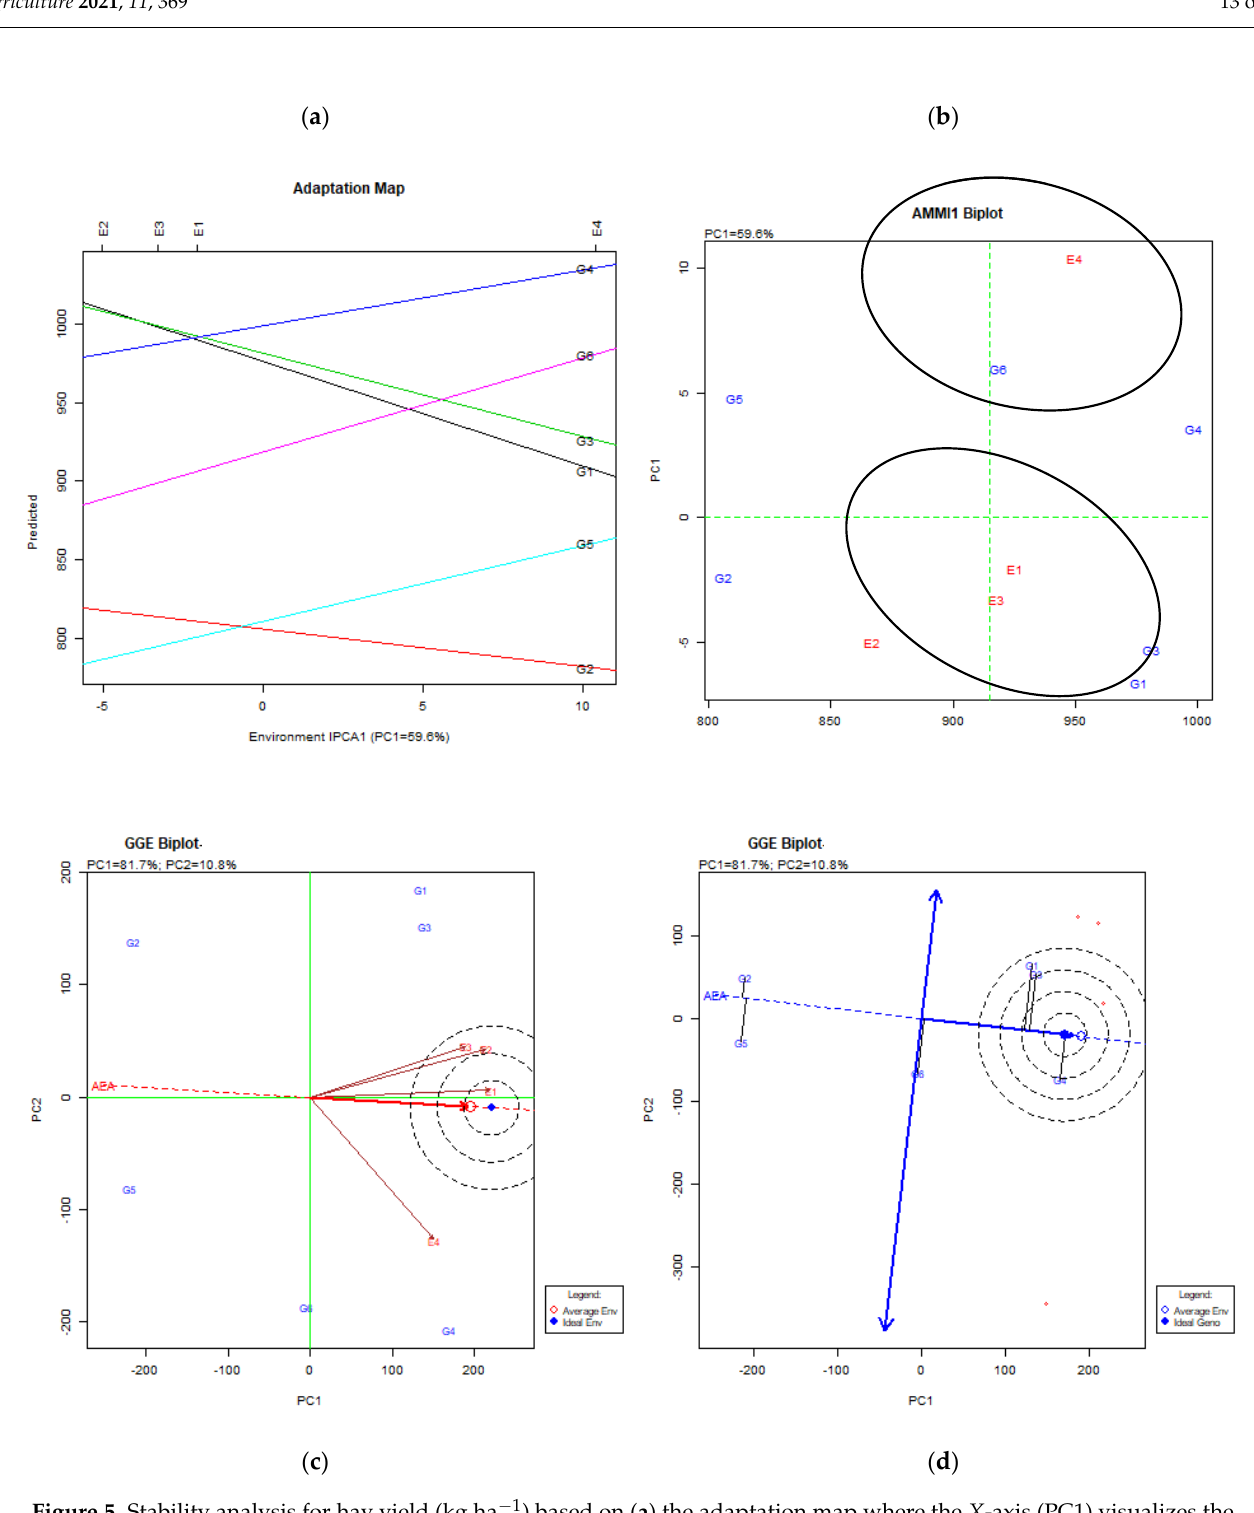
Figure 5. Stability analysis for hay yield (kg ha −1 ) based on ( a ) the adaptation map where the X-axis (PC1) visualizes the stability of varieties over environments and the Y-axis — the performance of varieties for the trait; ( b ) the AMMI1 biplot where the Y-axis is the one visualizing the trait performance and the X-axis (PC1) visualizes the stability of varieties over environments; ( c ) the GGE biplot for environments depicting the stability of the environments over years via the placement as near as possible to the ideal and average environment; ( d ) the GGE biplot for varieties depicting the stability of the varieties over environments where the productive varieties are those to the right on the AEA vector and the stable ones are those which are as close to the AEA axis as possible.